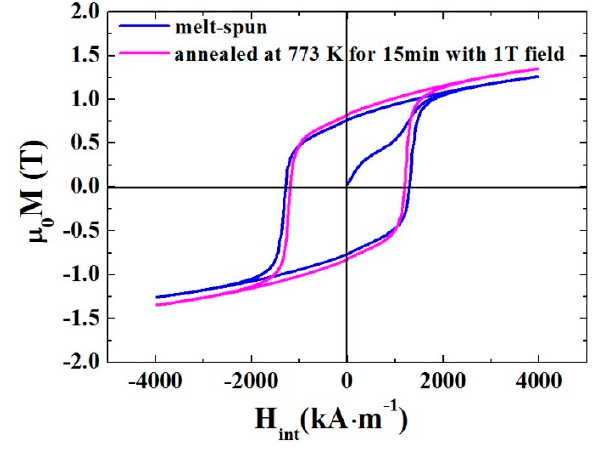
Figure 1. Hysteresis loops of melt-spun (Nd 0.8 Ce 0.2 ) 2.4 Fe 12 Co 2 B sample and the sample annealed at 773 K for 15 min with 1 T magnetic field.